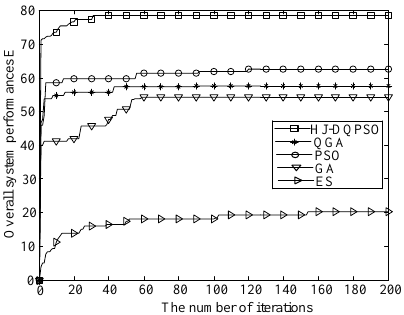
Figure 5 Overall system performances with